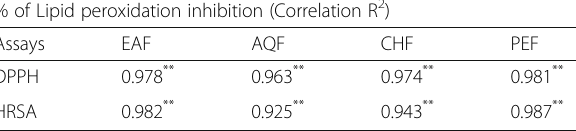
Table 3 Correlation coefficients between the % of lipid peroxidation inhibition (%LPI) with % of DPPH and Hydroxyl radicals scavenging activity (HRSA) of various fractions of T. pallida